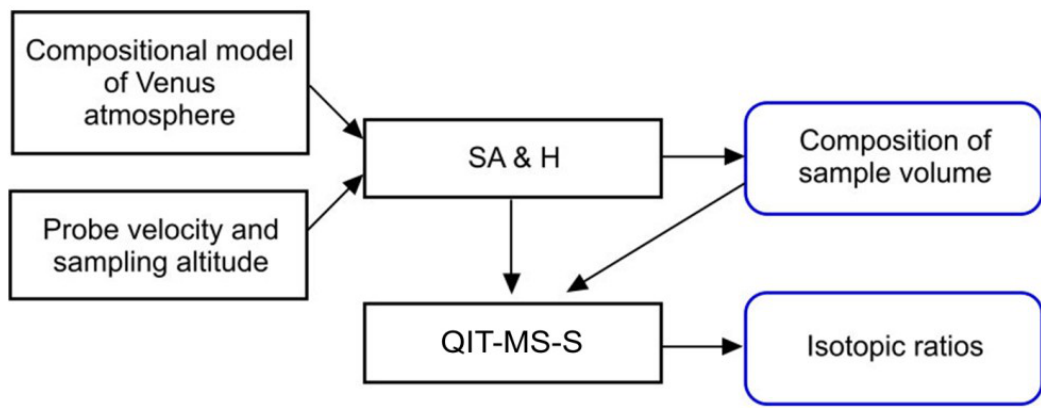
Figure 2. Modeling flow chart used in current investigation. The composition of the sample volume is calculated by the SA&H module using the composition of the Venus atmosphere and the probe trajectory. Isotopic ratios of noble gases are then calculated by QIT‐MS‐S module.